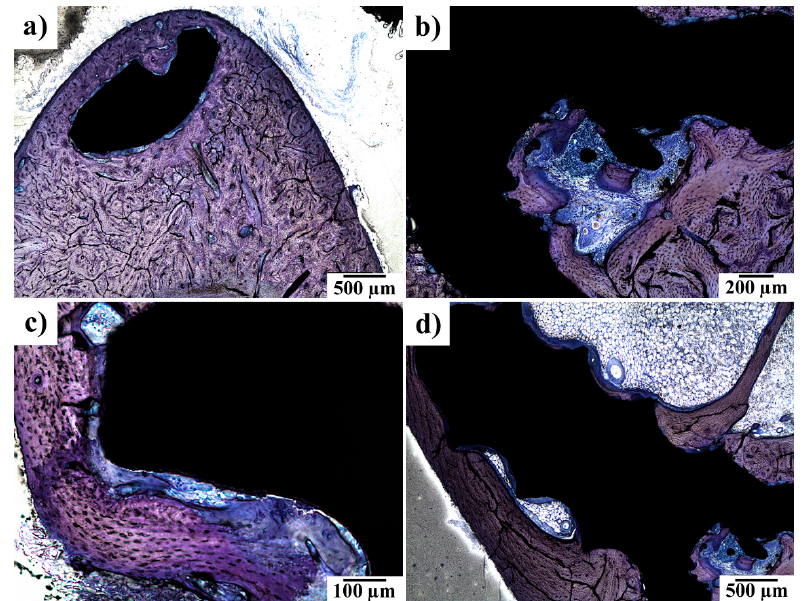
Figure 5. Histological examination of implant site with experimental screw. ( a ) Irregular osteon arrangement; ( b ) regular osteon arrangement. Note: the black field represents a histological cut of an experimental screw. Toluidine blue stained slides.